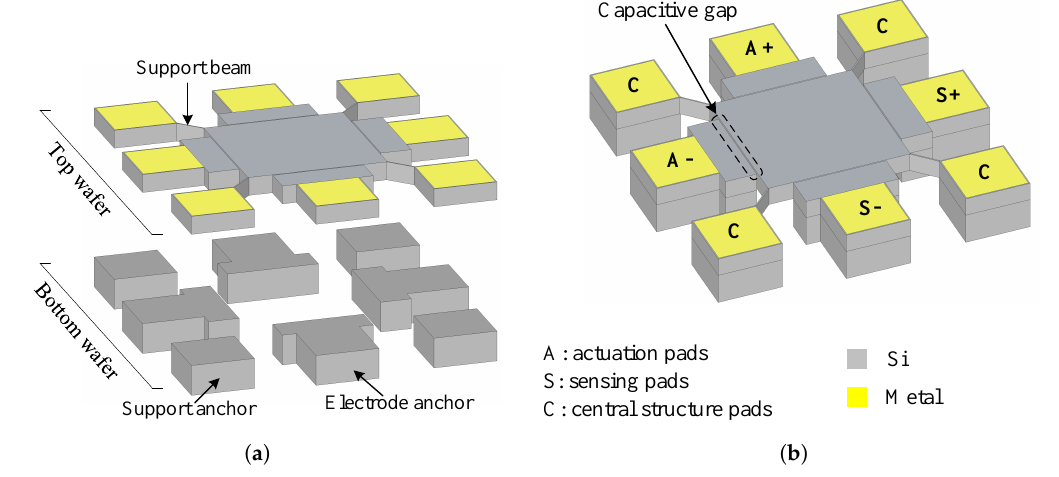
Figure 1. Simplified diagram of the ( a ) exploded and ( b ) assembled views of the Lamé-mode MEMS resonator with corner supports [1].